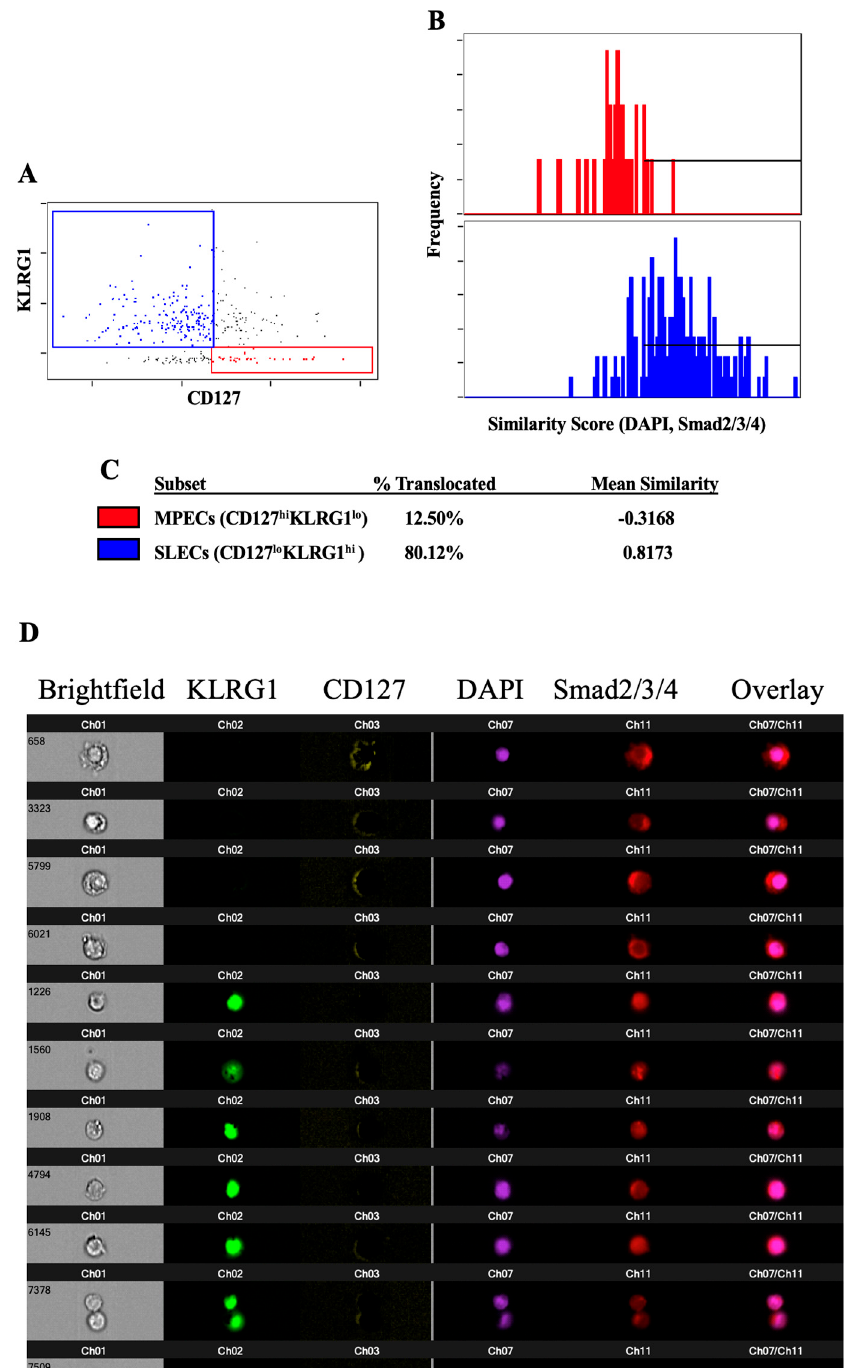
Figure 3. Smad proteins do not efficiently translocate to the nucleus in response to TGF β signaling in MPECs. Polyclonal CD8 T cells were stimulated with anti-CD3 ε and anti-CD28 mAbs for 5 days prior to a 4 h incubation with TGF β . The cells were then fixed, stained, and analyzed for the nuclear translocation of the Smad2/3/4. ( A ) Plot of KLRG1 and CD127 demonstrating the gating of MPECs (red) and SLECs (blue). ( B ) Plot of similarity values between fluorescence indicating the location of Smad2/3/4 and fluorescence indicating the location of the nucleus (DAPI) in MPECs (red) and SLECs (blue). Horizontal line indicates the similarity values that are consistent with the Smad translocation to the nucleus. ( C ) Calculated percentage of MPECs and SLECs in which Smad2/3/4 have translo- cated to the nucleus, according to the gate shown in ( B ), and the mean similarity value for each population. ( D ) Representative images showing the intensity and location of KLRG1, CD127, the